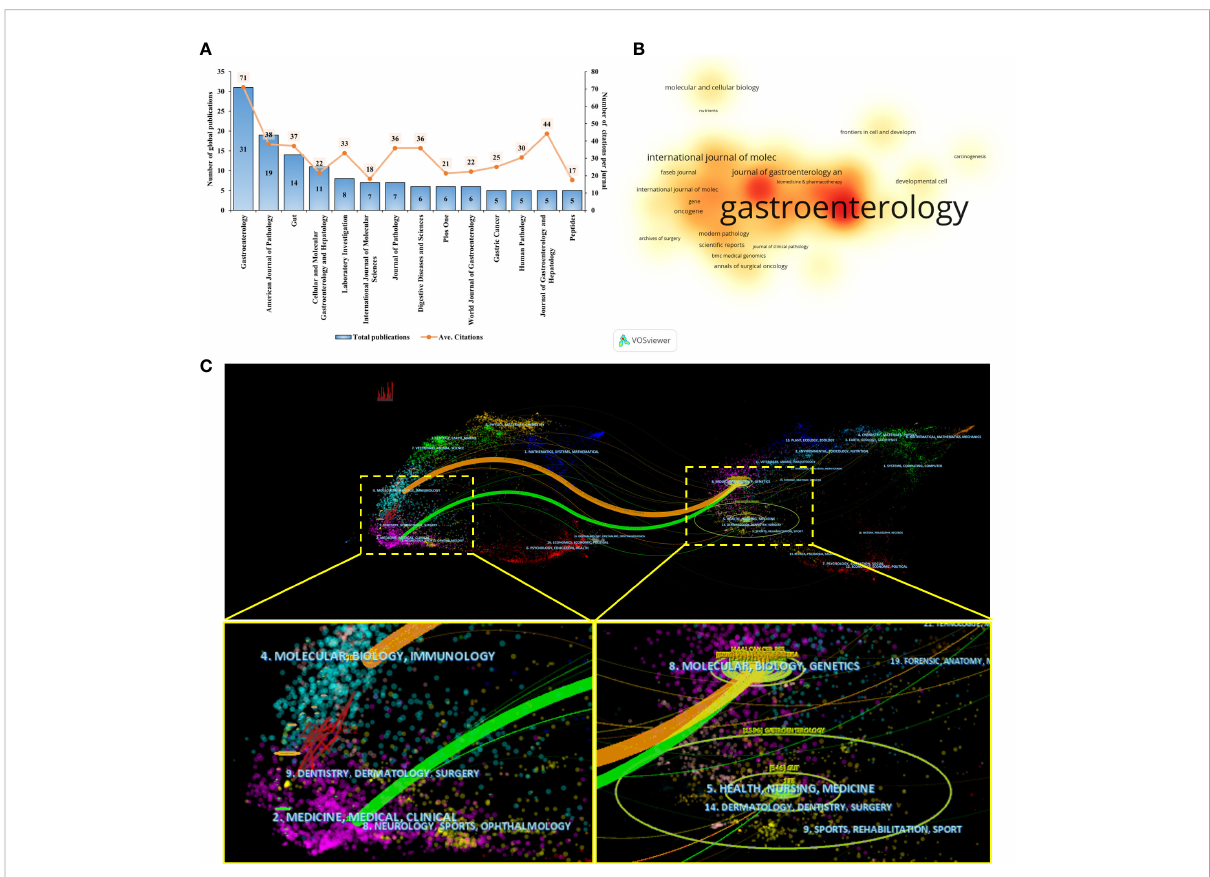
FIGURE 4 Visualization analysis of in fl uential journals. (A) The publications output and average citation of the top 10 journals in SPEM-GC. (B) VOSviewer was used to visualize the spectral density map of journals. A deeper color indicates a greater number of citations. (C) CiteSpace ’ s dual-map overlap of SPEM-GC journals. The citing journals are on the left, and the cited journals are on the right. The colored paths indicate their citation